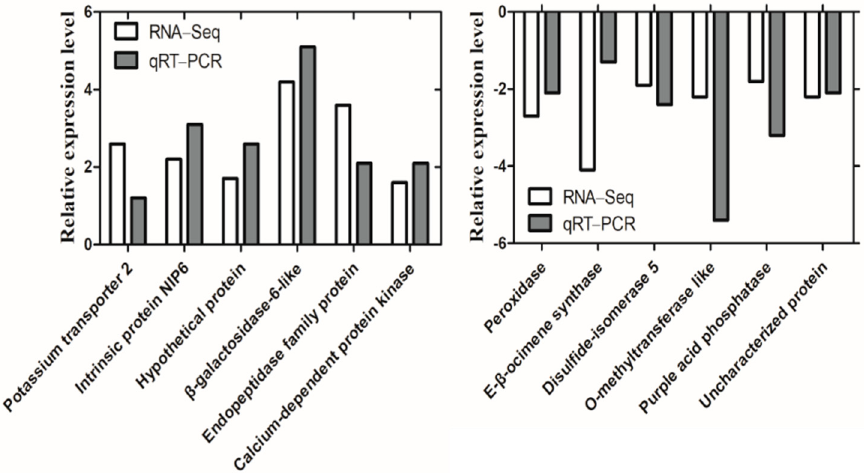
Figure 11. Twelve differentially expressed genes (DEGs) were validated by qRT − PCR. DEGs detected by transcriptome and qRT − PCR were present in white and gray columns, respectively.